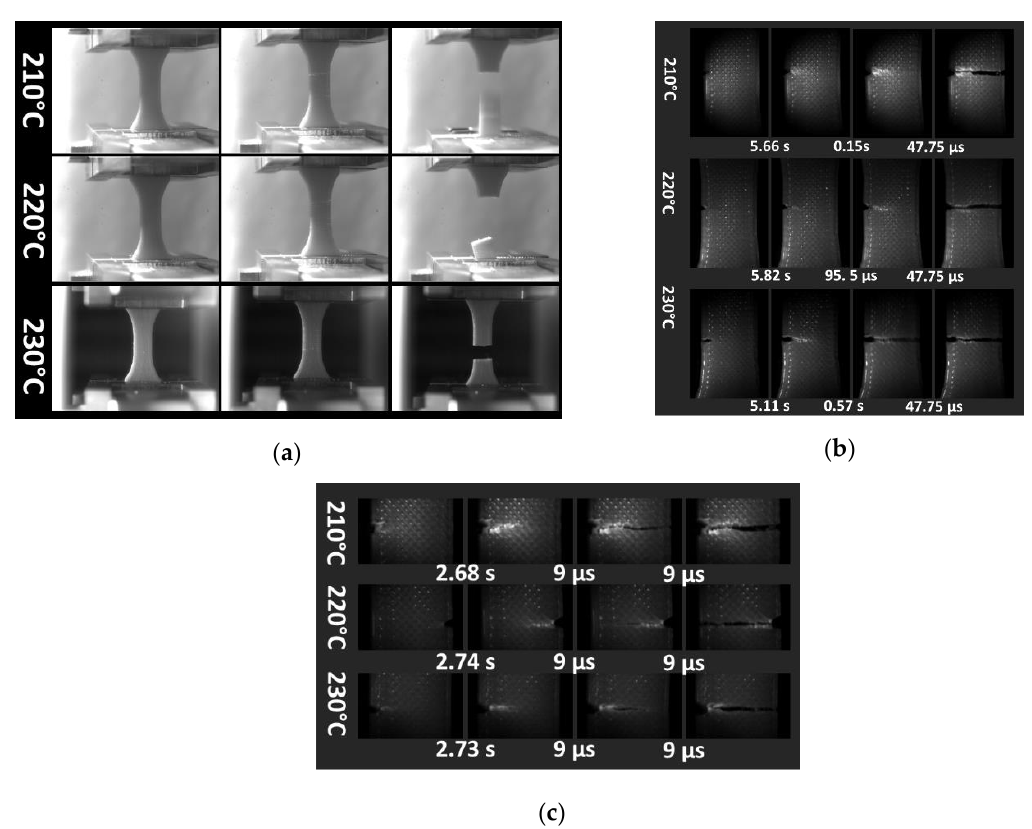
Figure 7. High speed camera recording of tensile test for: ( a ) neat and; notched 3D-printed PLA specimens at ( b ) intermediate, and ( c ) high speed observations.